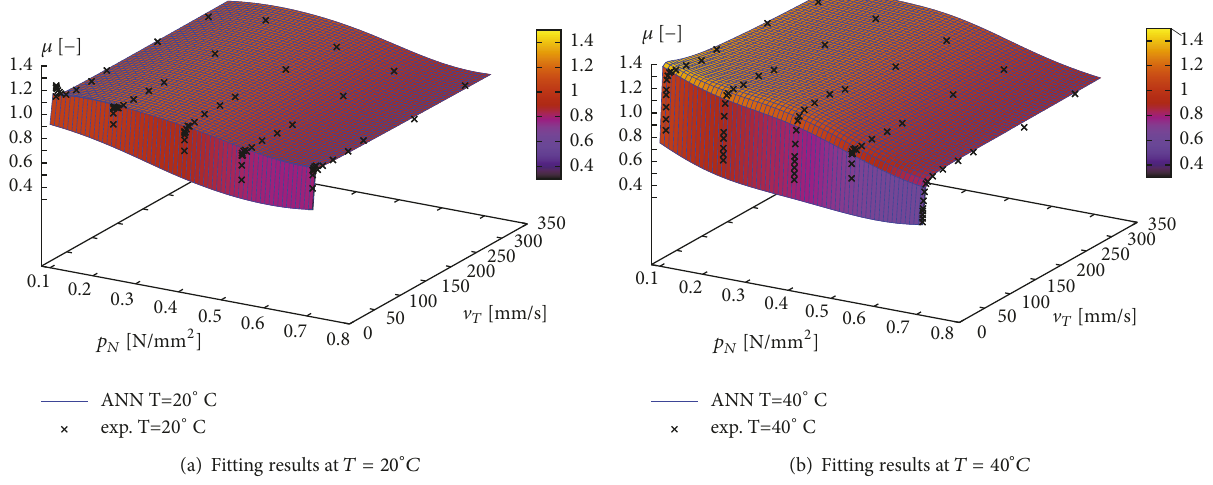
Figure 2: Friction coefficient response surfaces provided by ANN for experimental results at 𝑇 = 20 ∘ 𝐶 and 𝑇 = 40 ∘ 𝐶 .